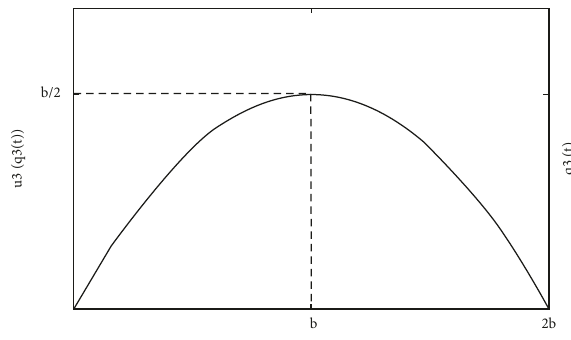
Figure 3: The payoff for forest inhabitants